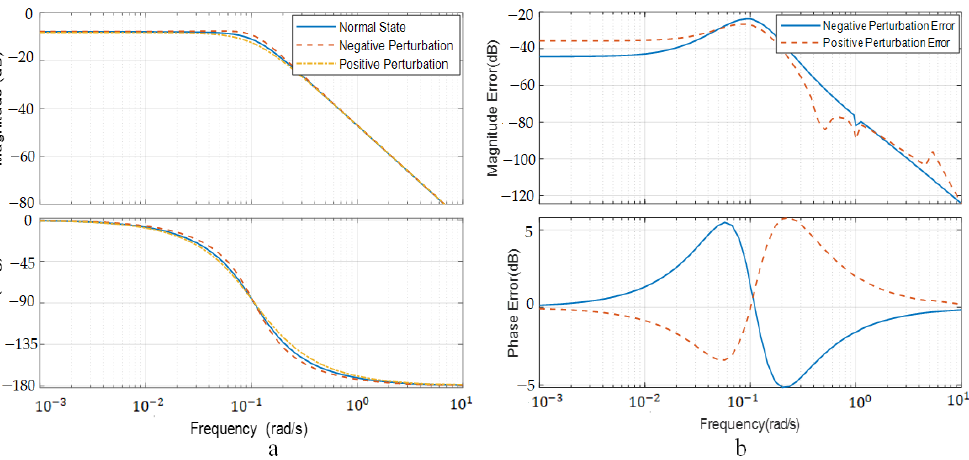
Figure 8. Bode Plot and Deviation Curve of Axial Mass Center Perturbation for Pitching Channel: (a) Bode diagram of the pitch channel under the state of perturbation of the pitch axial position, (b) amplitude frequency and phase frequency error curves of the pitch channel under the state of perturbation of the axial position.